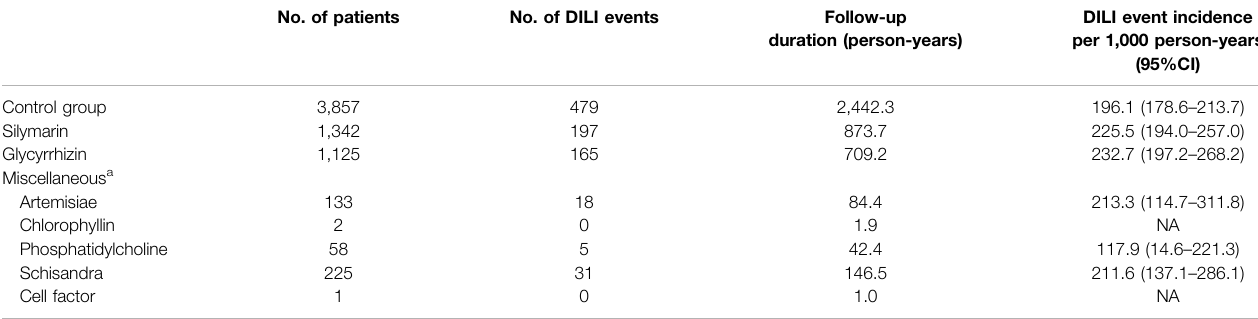
TABLE 2 | Frequency of new initiation of preventive hepatoprotective agents in